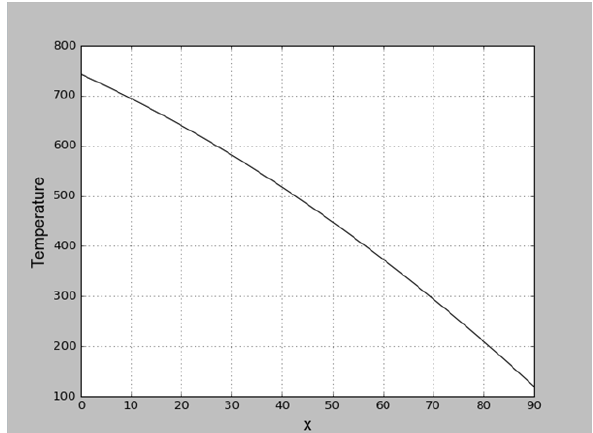
Figure 2: The field of temperature distribution along the length of the